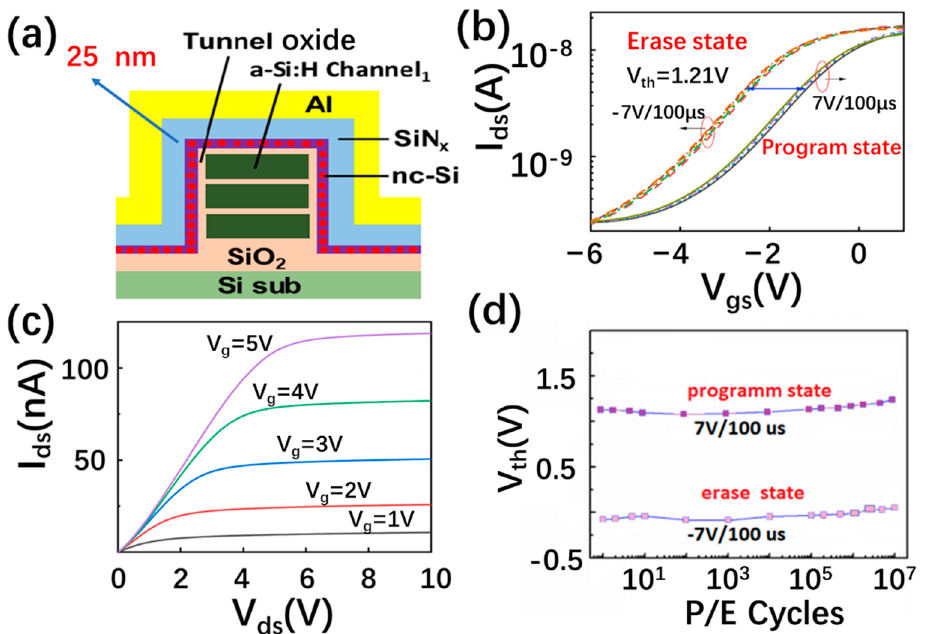
Figure 6. ( a ) The schematic diagram of the nc-Si floating-gate memory with a SiN x thickness of 25 nm. ( b ) The erasing and programming characteristics of the 3D nc-Si floating-gate memory with a SiN x thickness of 25 nm. The programming and erasing speeds are +7 V/100 us and − 7 V/ − 100 us ( c ) The output characteristics of the 3D nc-Si floating-gate memory with a SiN x thickness of 25 nm. ( d ) The endurance characteristics of the 3D nc-Si floating-gate memory with a SiN x thickness of 25 nm after the 10 7 P/E cycle operations at +7 V/100 us and − 7 V/100 µs.